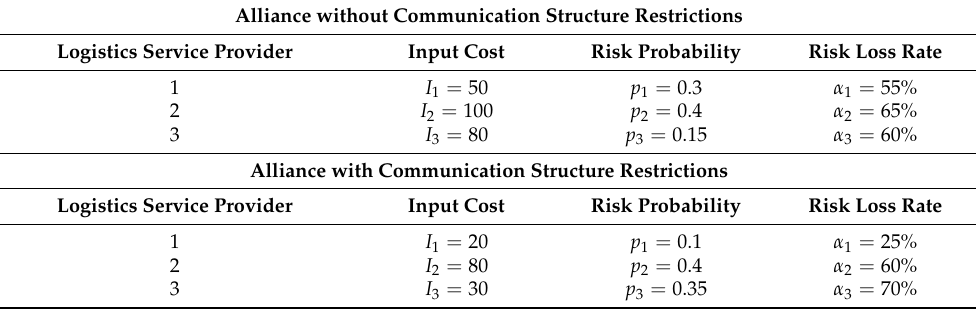
Table 4. Parameter values of risk-taking in logistics